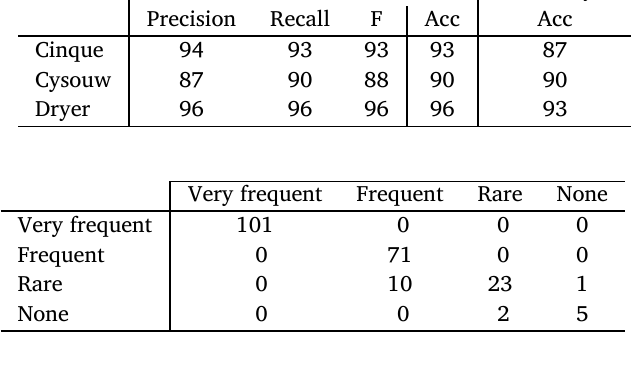
Confusion Matrix of WAODE classifier for Dryer’s model.